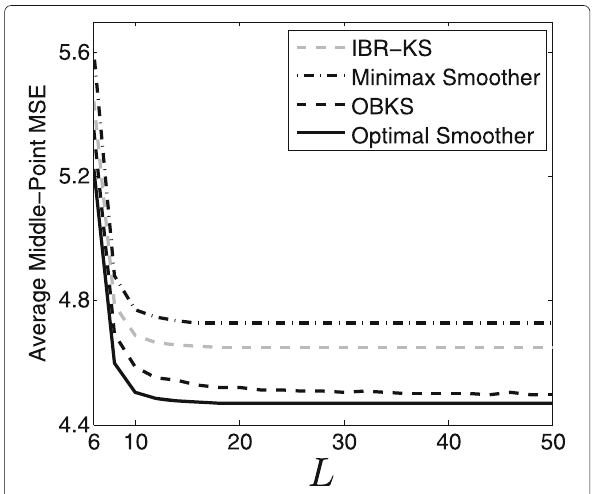
Fig. 8 Effect of the size of observations on the smoother performance in the target tracking example with unknown r and q